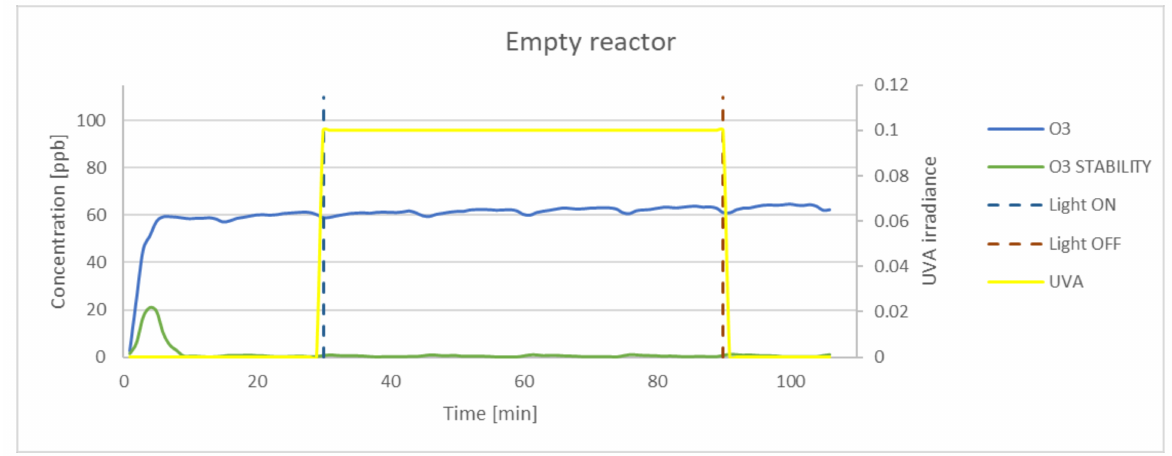
Figure 13. The oxidation of O 3 in the empty reactor under UVA irradiation. Data on UVA irradiation are shown in the supplementary chart. Dashed lines indicate the time of light on and